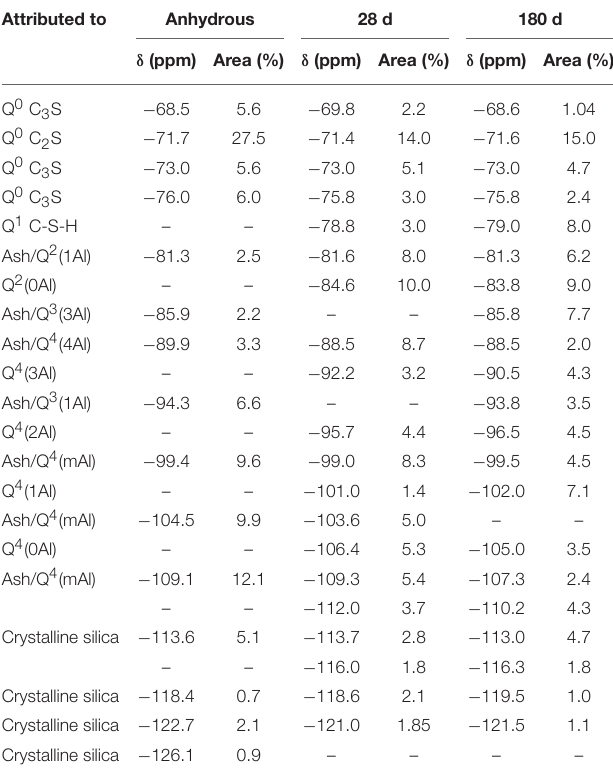
TABLE 3 | Chemical shifts (ppm) recorded after deconvolution of 29 Si MAS NMR spectra for hybrid cement and 28 d and 180 d cement